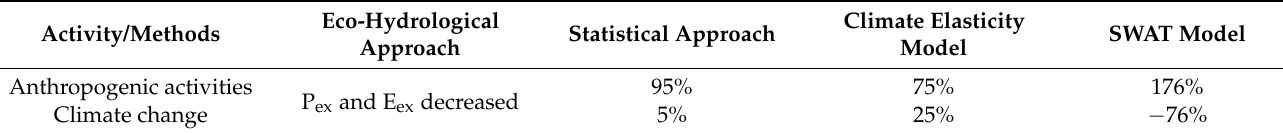
Figure 14. The graph between observed and reconstructed flow using SWAT model for the post- change period. Table 9. Differentiating the impacts of climate change and anthropogenic activities on the runoff of the KRB using different